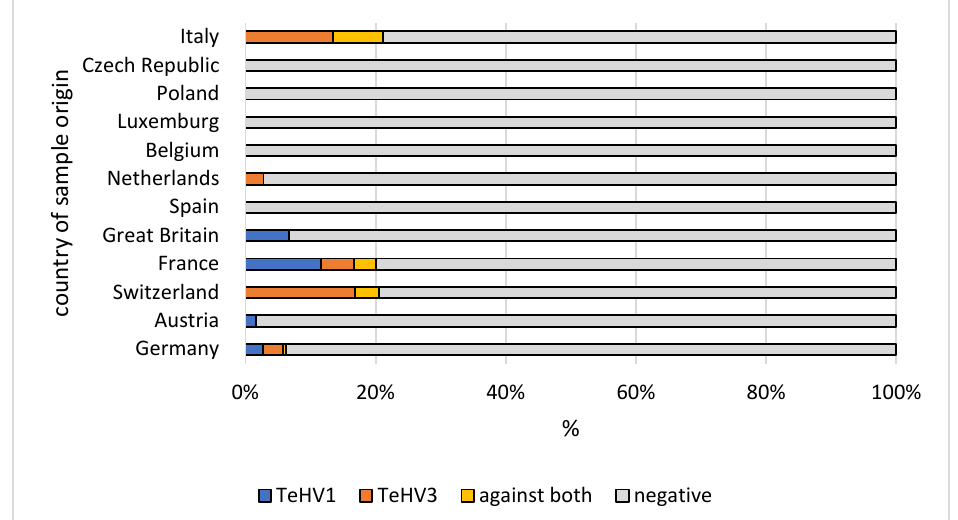
Figure 6. Herpesvirus (TeHV1 and TeHV3) antibody detection rates (titer 2 or higher) in five Testudo